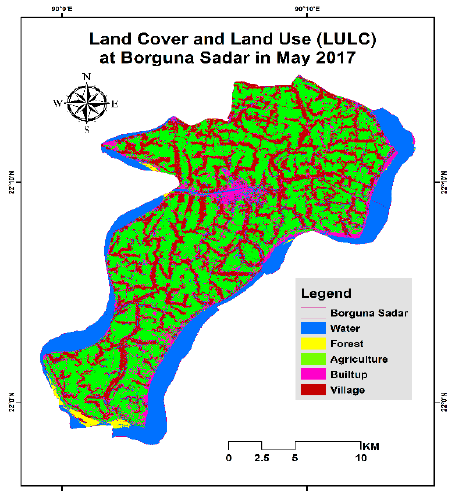
Figure 4. Land Use–Land Cover